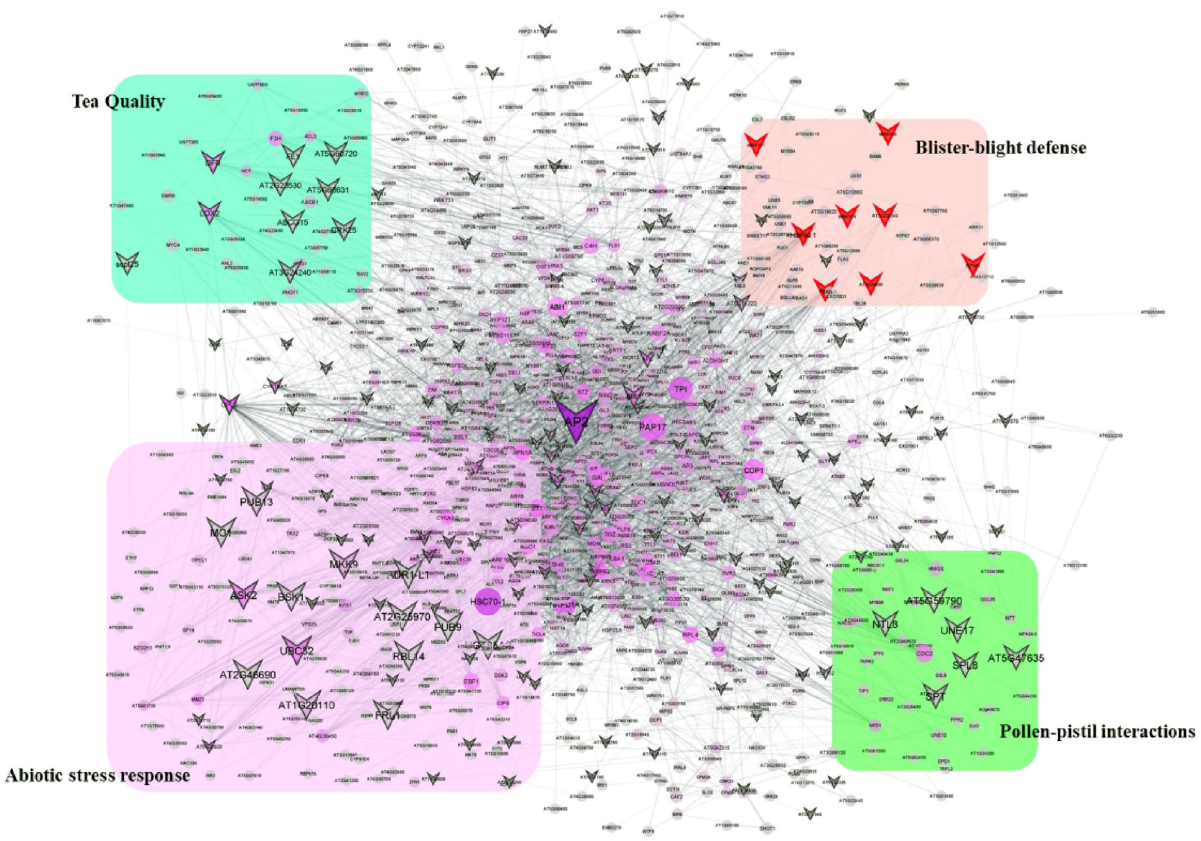
Figure 5. Protein–protein interaction (PPI) network analysis: PPIN prediction of transcription factors harbouring SSRs including polymorphic SSR markers using Cytoscape v3.4 (https:// cytos cape.